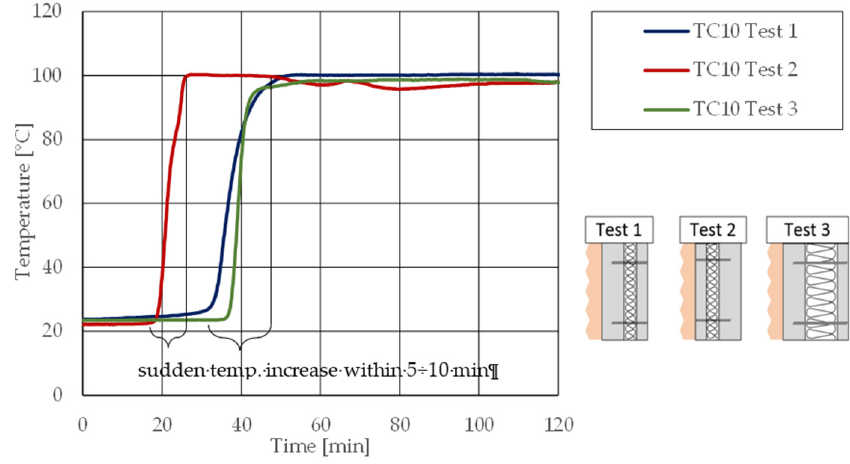
Figure 8. Temperature in the plane between the insulation and the concrete wythe not exposed to fire.